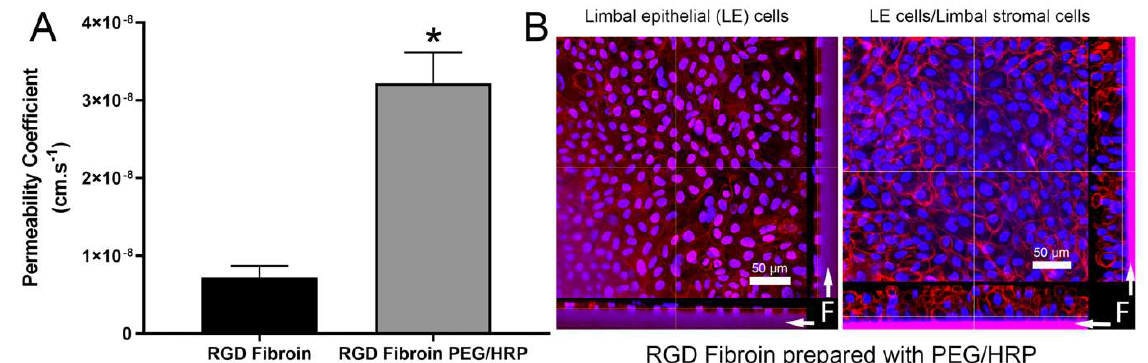
Figure 6. Permeability characteristics of RGD-Fibroin membranes. ( A ) Relative permeability of RGD-Fibroin compared to RGD-PEG/HRP-Fibroin examined by diffusion of Allura Red AC (MW 496.4 Da). Bars represent mean ± standard deviation from four separate measures. Asterisk indicates significantly different value to RGD-Fibroin ( p < 0.0001; non-paired two-tailed t test). ( B ) Further evidence of membrane permeability is provided by demonstrating increased stratification (confocal microscopy) of limbal epithelial cell cultures (LE) when grown on RGD-PEG/HRP-Fibroin membranes in the absence and presence of limbal stromal cells (cultivated on the opposing membrane surface; beyond field of view imaged). Parallel cultures prepared from the same donor’s LE cells were maintained for 12 days prior to fixation and staining with rhodamine phalloidin (red/pink) and Hoechst nuclear stain (blue). Fibroin membrane (labelled “F” with arrows) is visible within the Z profile views (at the bottom and right-hand side of each image) due to a combination of autofluorescence and some residual excess rhodamine phalloidin.